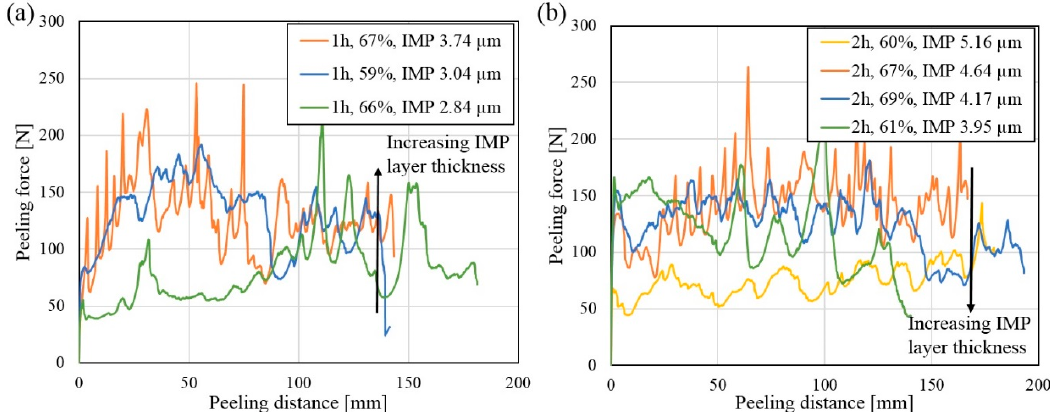
Figure 13. The measured peeling force necessary to delaminate the composites heat treated at 450 °C for ( a ) one hour and ( b ) two hours, as a function of peeling distance. The total thickness reduction of the composite together with the measured IMP layer thickness in the composites are given in the legends.